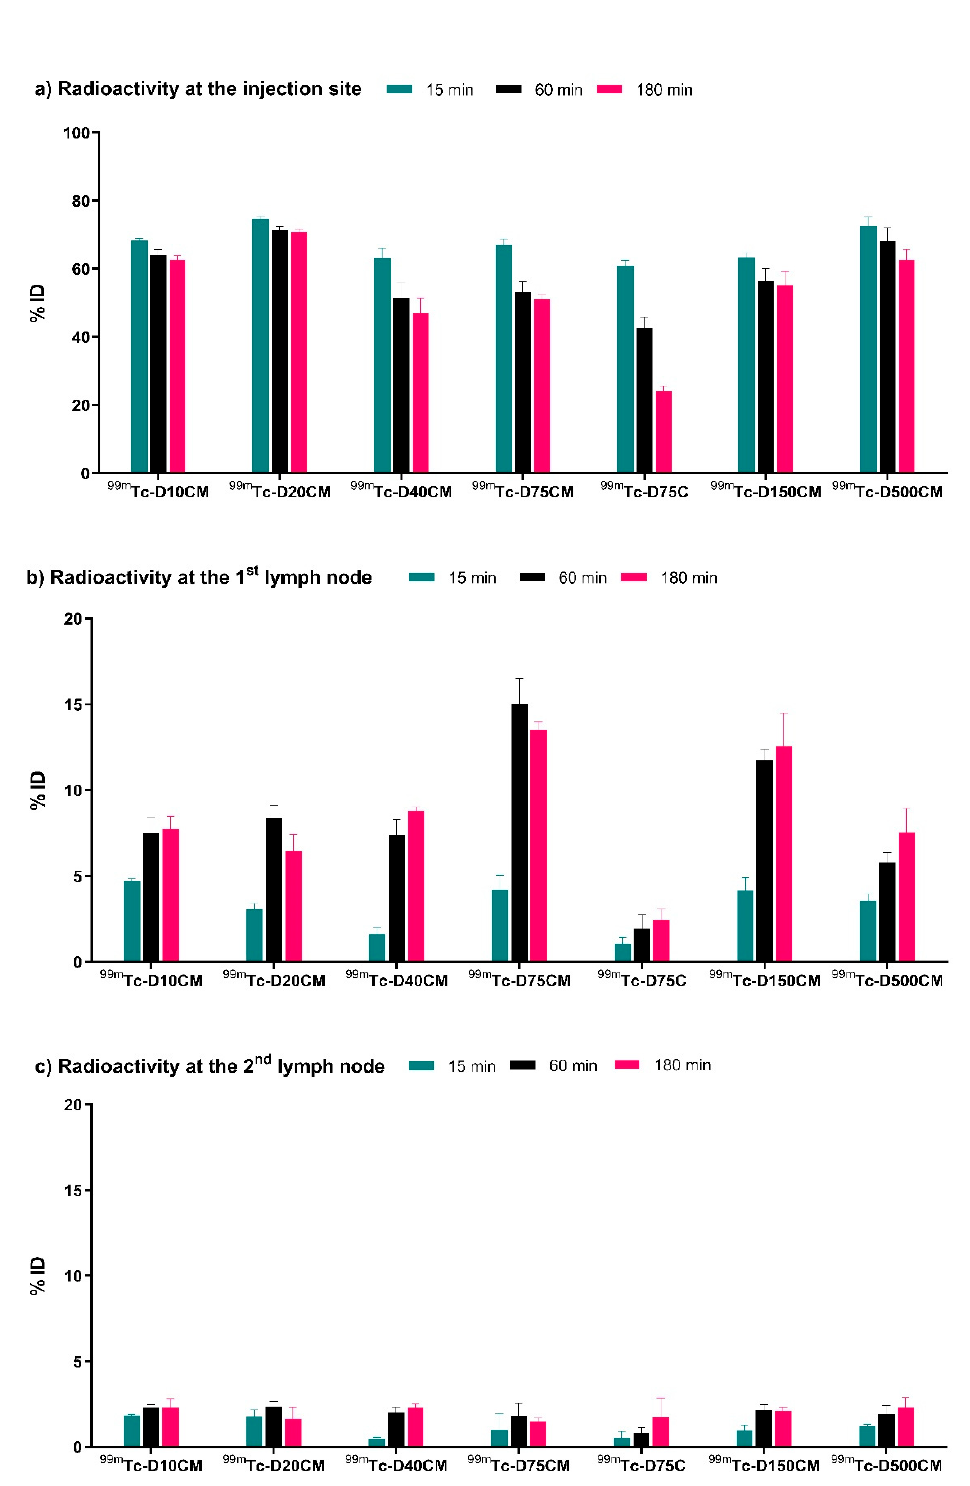
Figure 3. Biodistribution of radioactivity in the 1st and 2nd lymph nodes and at the injection site after subcutaneous injection of 99m Tc-complexes to the rear footpad of healthy Swiss Albino mice at ( a ) 15, ( b ) 60, and ( c ) 180 min.